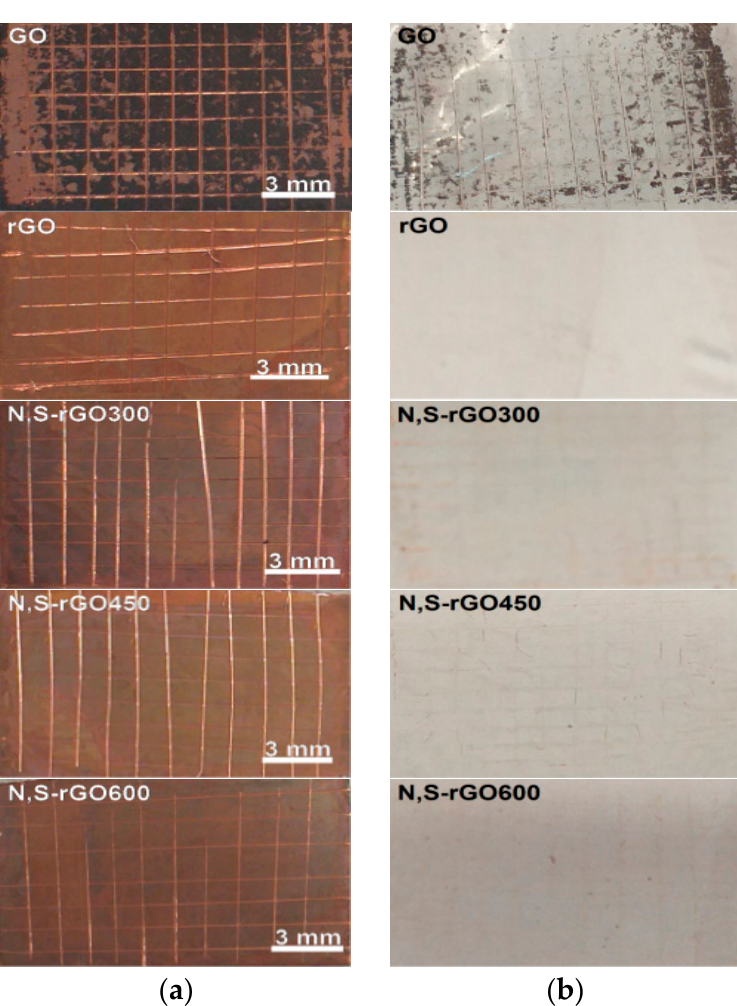
Figure 7. The thickness of graphene coatings.